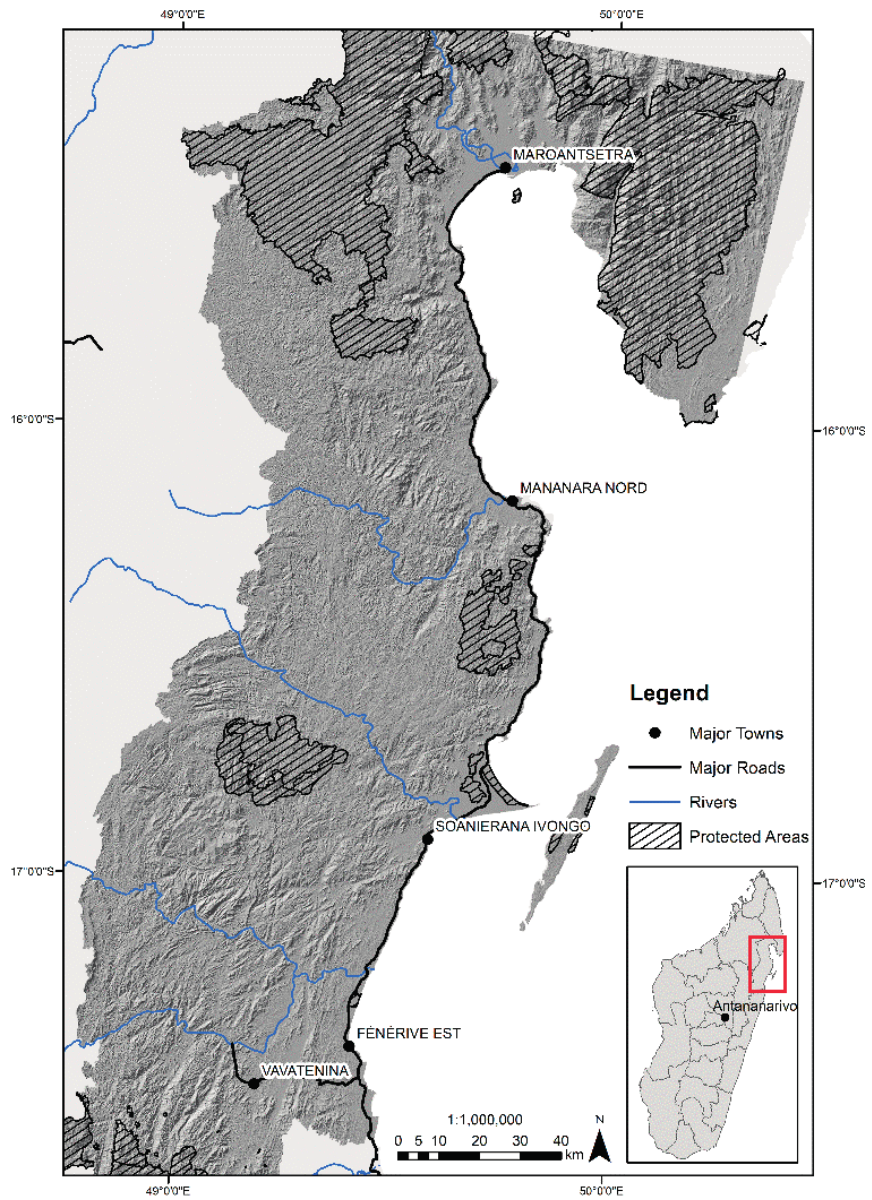
Figure 1. Study region location in north-eastern Madagascar showing major towns, roads, rivers, and protected